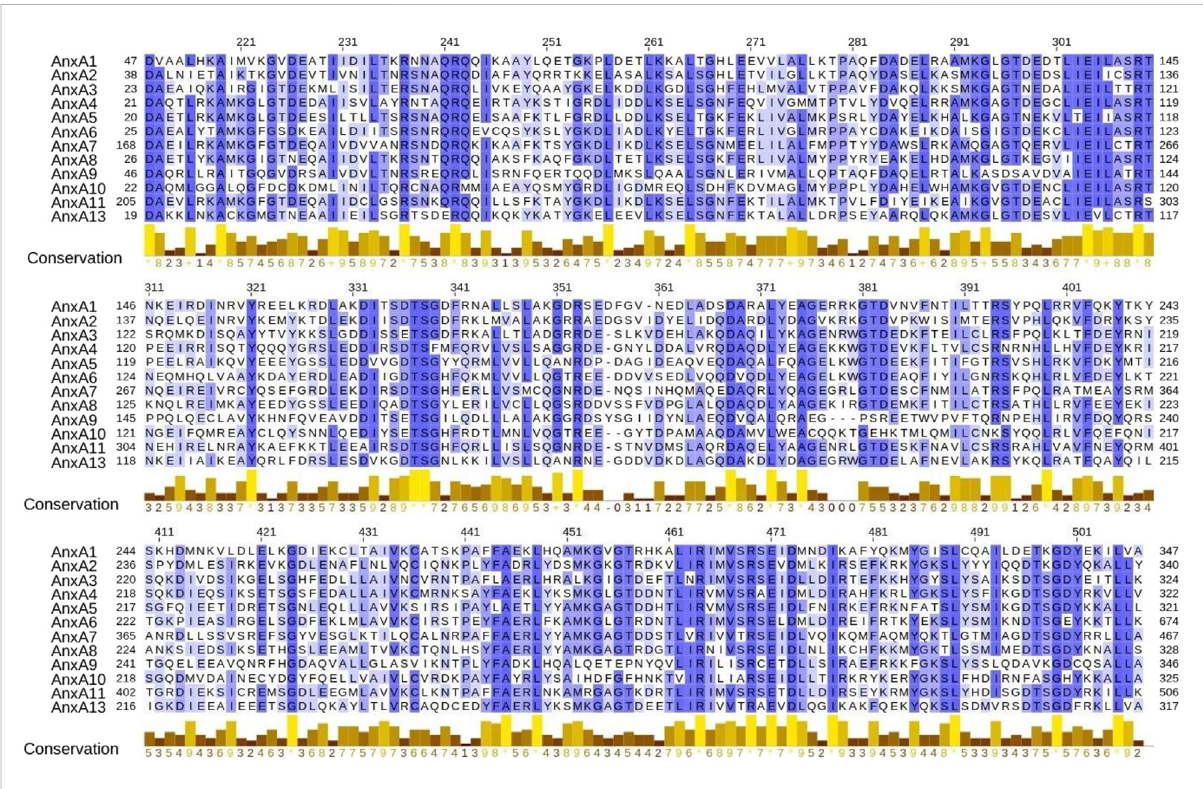
FIGURE 2 Protein sequence similarity of human AnxA1 to AnxA13. Multiple sequence alignment of annexins using amino acid complete sequences from canonicaltranscripts.Forvisualizationpurposes,thealignmentistrimmedtoshowonlythesharedfourdomains.Aminoacidsarecoloredaccording to the percentage of identity. Conservation score of amino acid properties is shown per position. Amino acid sequences from proteins AnxA1 to AnxA13 where retrieved from Ensembl biomart, using GRCh38 human genome assembly and canonical transcripts. Multiple sequence alignment (MSA) was performed using Clustal Omega (Sievers et al., 2011). MSA was visualized, annotated with conservation score and trimmed to the region where all 12 shared the four domains using Jaview (Waterhouse et al.,